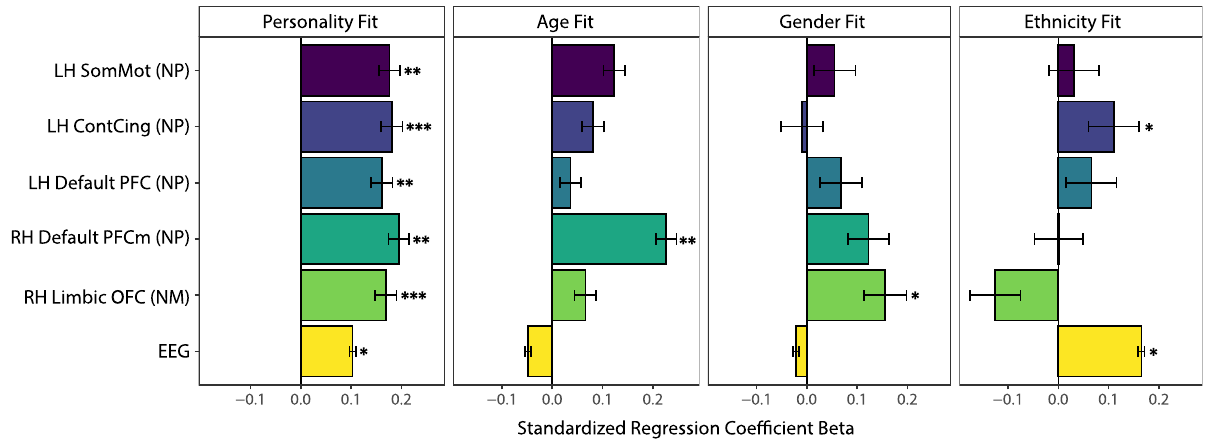
Figure 5. Effect sizes comparison. Comparing effect sizes between personality similarity and all socio- demographic measures available in both fMRI and EEG (using the main Euclidean distance similarity metric). LH left hemisphere, RH right hemisphere, NM neural magnitude synchrony, NP neural pattern synchrony, SomMot somatomotor cortex, ContCing cingulate cortex parcel within frontoparietal control network, Default PFC prefrontal cortex parcel within the default mode network, Default PFCm medial prefrontal cortex parcel within the default mode network, Limbic OFC orbitofrontal cortex parcel within the limbic network. Asterisks indicate permutation-tested significance levels with * p < 0.05, ** p < 0.01, *** p <